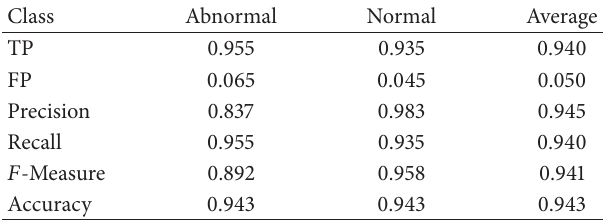
Table 4: The performance evaluation of predicted normal and abnormal RBC